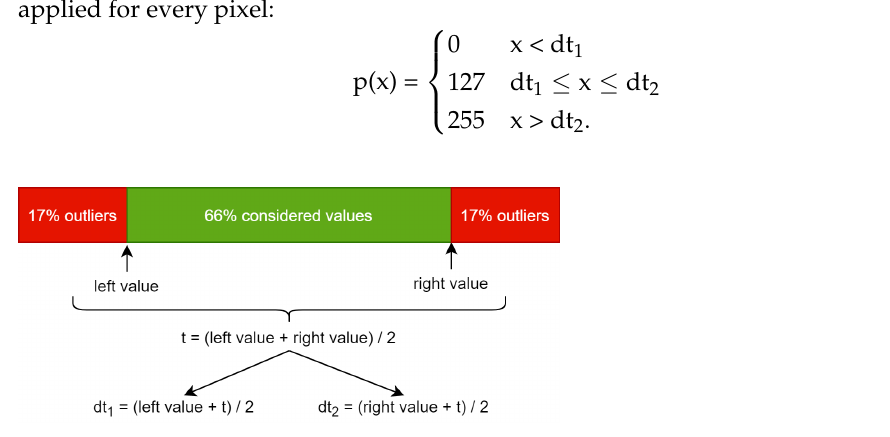
Figure 1. The process of computing thresholds. t represents the threshold which can be used to convert grayscale to black and white. dt 1 and dt 2 represents the thresholds used to convert from grayscale to black–gray–white The procedure for cutting edges to remove outliers is performed for safety in the case of extreme values appearing in overexposed frames. This percentage of outliers’ removal is configurable but the resulting threshold was similar for values between 5% and 20% in many cases, with a difference up to four units. However, there is no definition of a perfect threshold for a specific frame. The most important thing is to have a resulting image in which specific features of the face can be observed. Figure 2 presents an example of a converted image using the two thresholds.